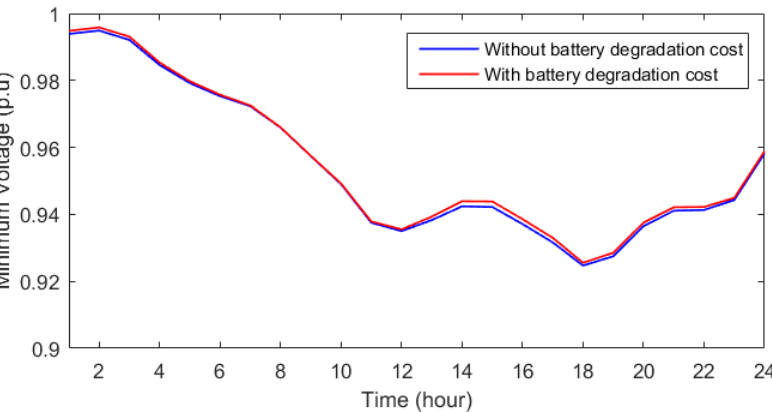
Figure 14. Received grid power without and with battery degradation costs using the IGJO. The curve of minimum network voltage changes during 24 h as well as the network voltage profile are presented in Figures 15 and 16, respectively. The results show that by considering the cost of battery degradation, the voltage conditions have improved and the amount of voltage deviations compared to the state without considering the cost of battery degradation is reduced.